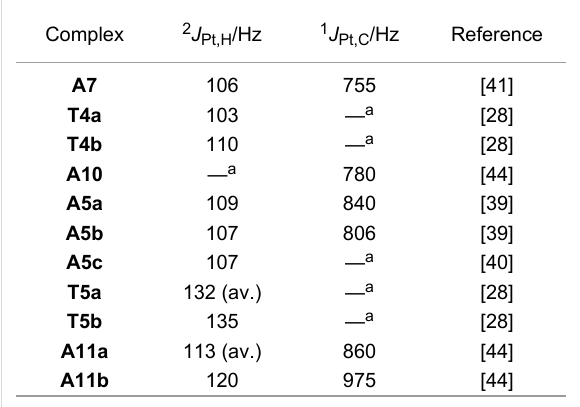
complex trans -[PtH(P t -Bu 3 ) 2 ][X] T1 (X = PF 6 , BF 4 , ClO 4 ,